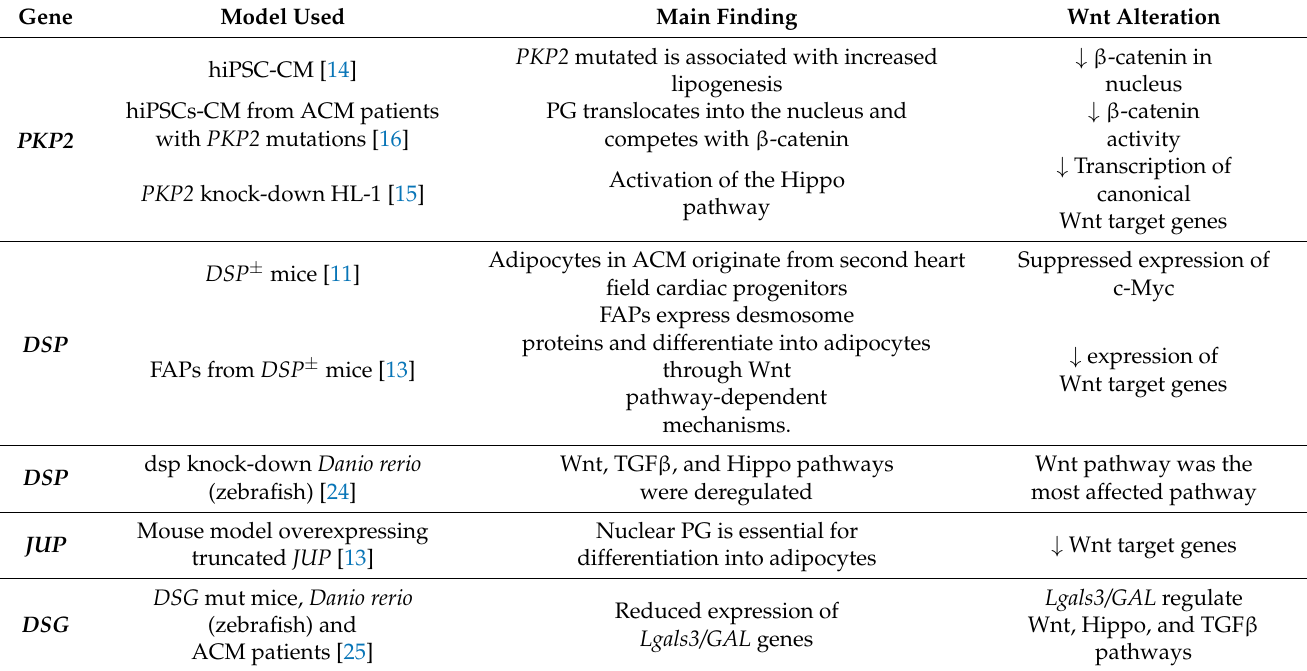
Table 2. Main findings supporting the role of the Wnt/ β -catenin pathway in different genetic